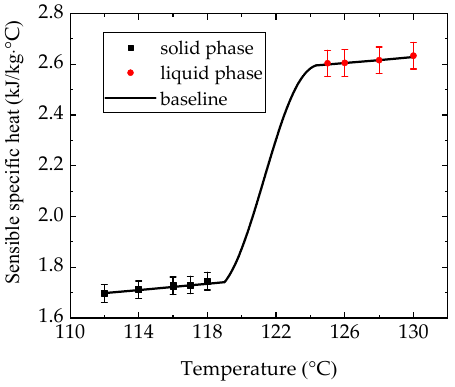
Figure 15. Sensible specific heat value of erythritol.